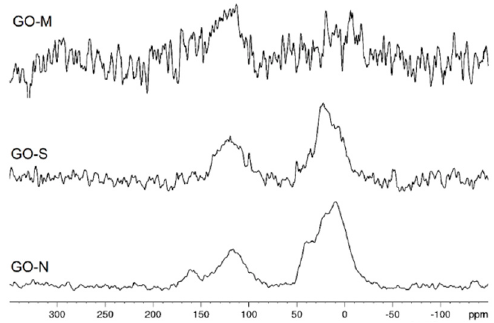
Figure 4. 13 C CPMAS spectra of samples GO-N, GO-S, and GO-M.